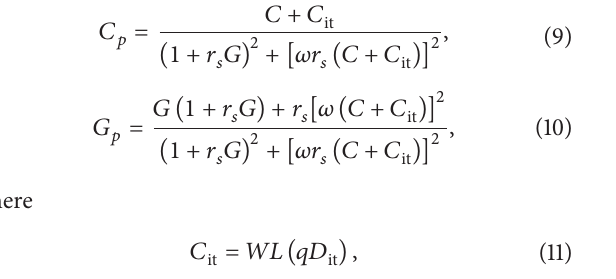
Table 2: Summarizing table of the interface trap capacitance 𝐶